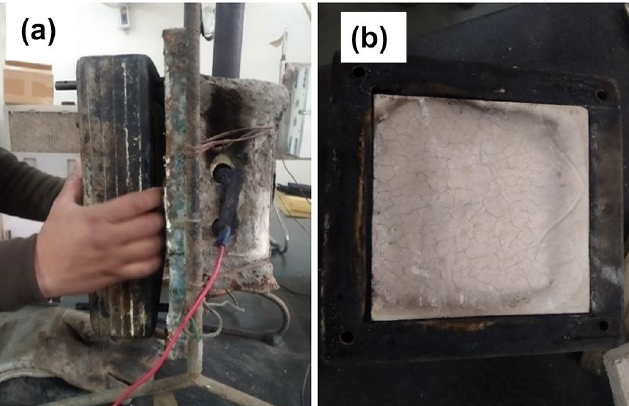
Figure 12. ( a ) Fire propagation index test of agro-waste gypsum samples, ( b ) surface of agro-waste gypsum sample tested for fire propagation